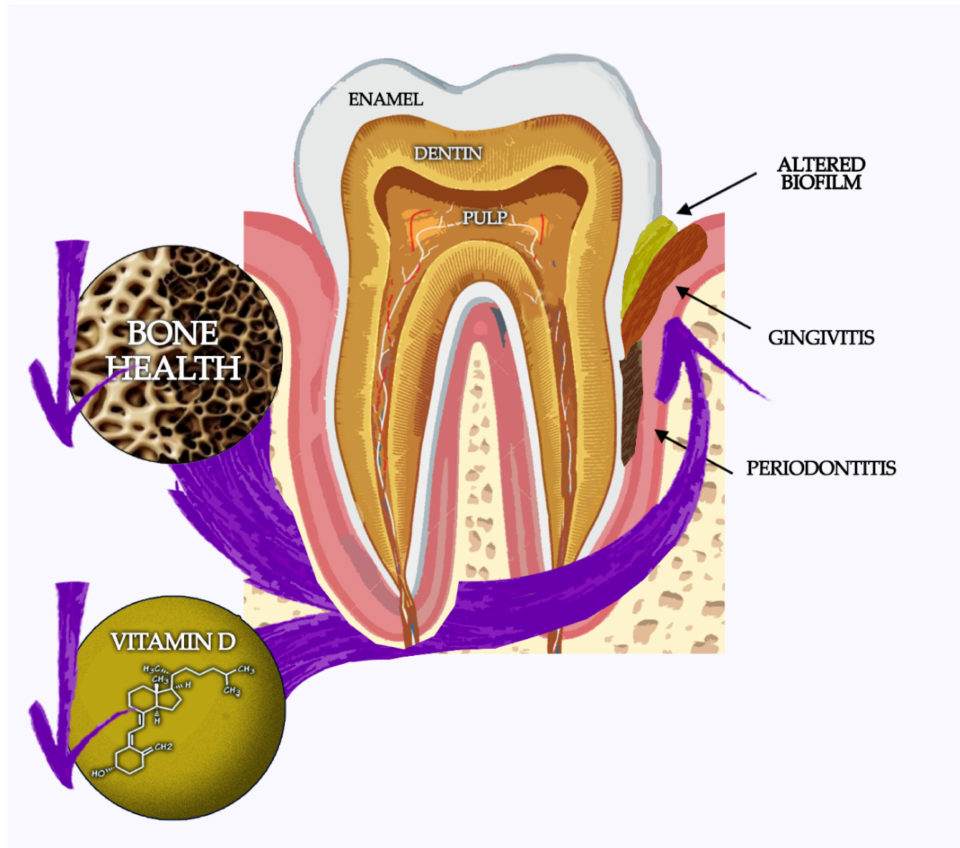
Figure 1. Correlation among oral health, bone mineral density, and vitamin D